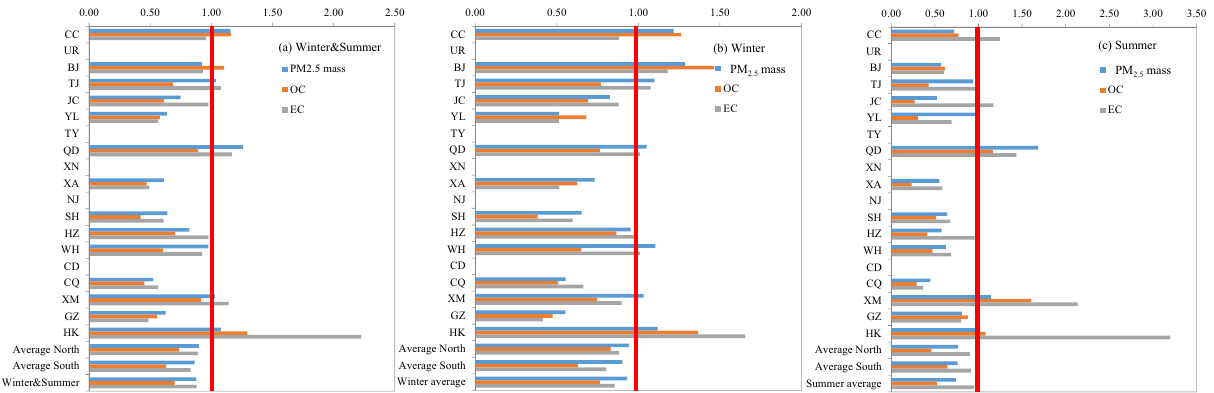
Figure 3. Ratios of 2013 to 2003 measurements for PM 2.5 mass, OC, and EC concentrations in 14 cities (See Table 1 for site descriptions). No data available for Urumqui [UR], Taiyuan [TY], Xining [XN], Nanjing [NJ], and Chengdu [CD] in the 2003 study 24